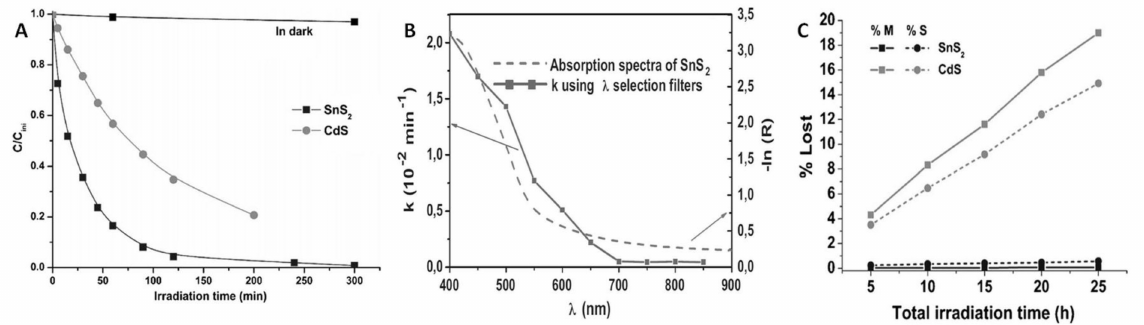
Figure 10. ( A ) Comparison of the aqueous HCOOH photodegradation activity between SnS 2 and CdS; ( B ) SnS 2 spectral response in the same process; ( C ) comparing the photocorrosion rate, evaluated from the amount of the sulfide components appearing in the solution, between CdS and SnS 2 (Adapted from Ref. [155]).